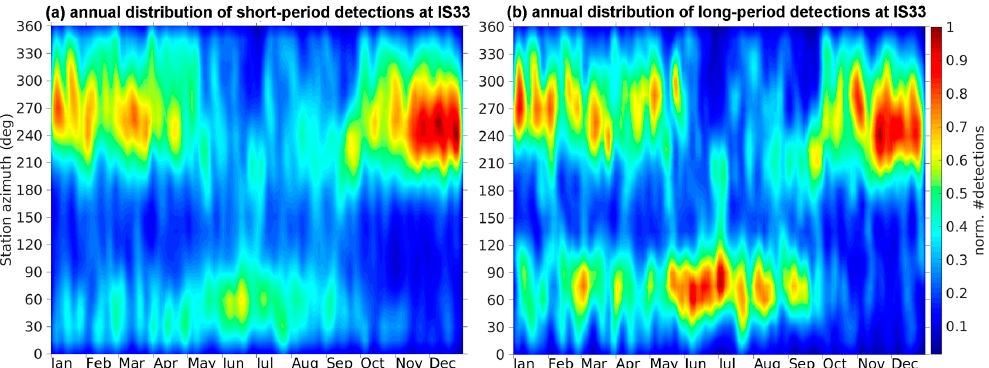
Figure 5. Distributions of the annual detections at IS33, stacked over 10 years. The respective maximum normalizes each distribution. The number of detections was evaluated per 5 d and 30°. Both the short-period ( a ) and the long-period ( b ) configuration show similar seasonal variations. The variation in detections and azimuth is compared to the 10 m wind at the stations, with regard to the impression of Figure 3, according to which the monthly-mean back-azimuths of the detections followed the prevailing tropospheric wind directions. Figure 6 compares the time series of detections with the wind direction (blue) and wind speed (red) at IS33. Obviously, the detections’ azimuths correlate with the wind direction, especially detections originating from the west. At the same time, the wind speeds are at the annual minimum (around 1–2 m s − 1 ); contrarily, detections from the east coincide with higher seasonal wind speeds (around 3–4 m s − 1 ). In the winter, the stronger winds blowing from the ocean reduce the detection capability of the station since these cause more turbulent noise. The detection capability can also be an explanation for the reduced number of detections from the east, specifically at short periods.